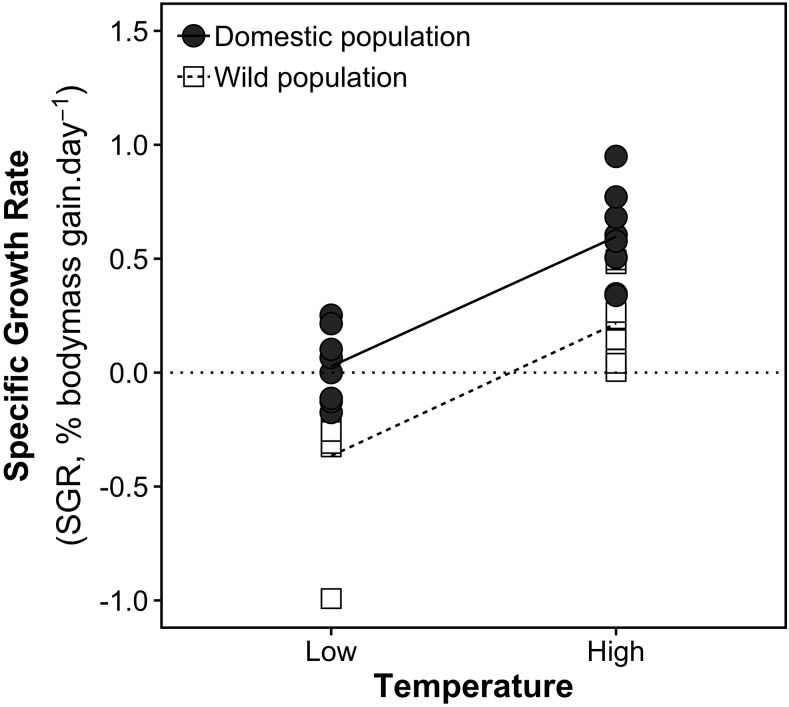
Specific growth rates of wild and domesticated C. auratus (8n/treatment) at the start and end of the low and warm temperature experiment.